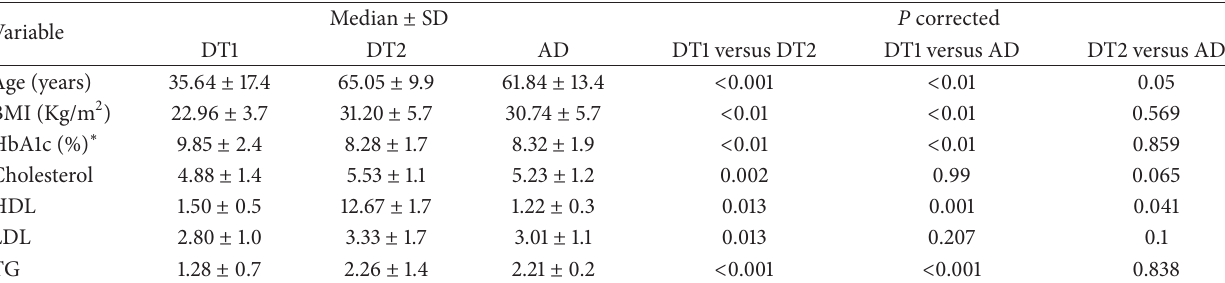
Table 1: Clinical characteristics of diabetes